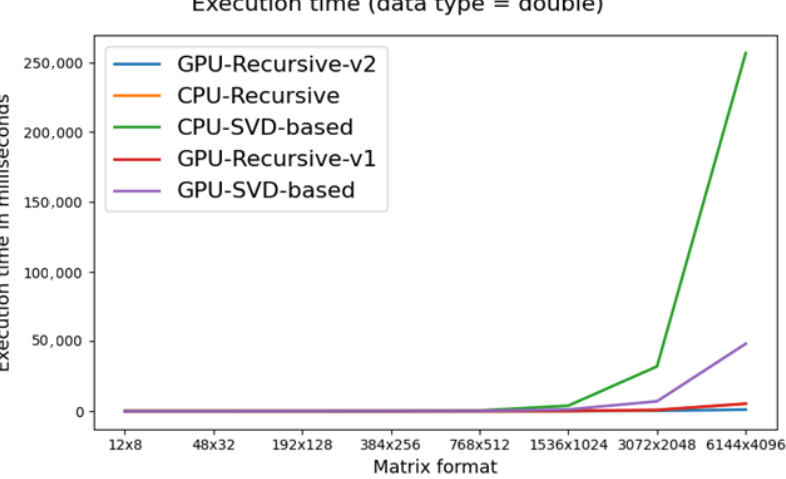
Figure 8. Time in milliseconds to calculate the pseudoinverse of double matrix.